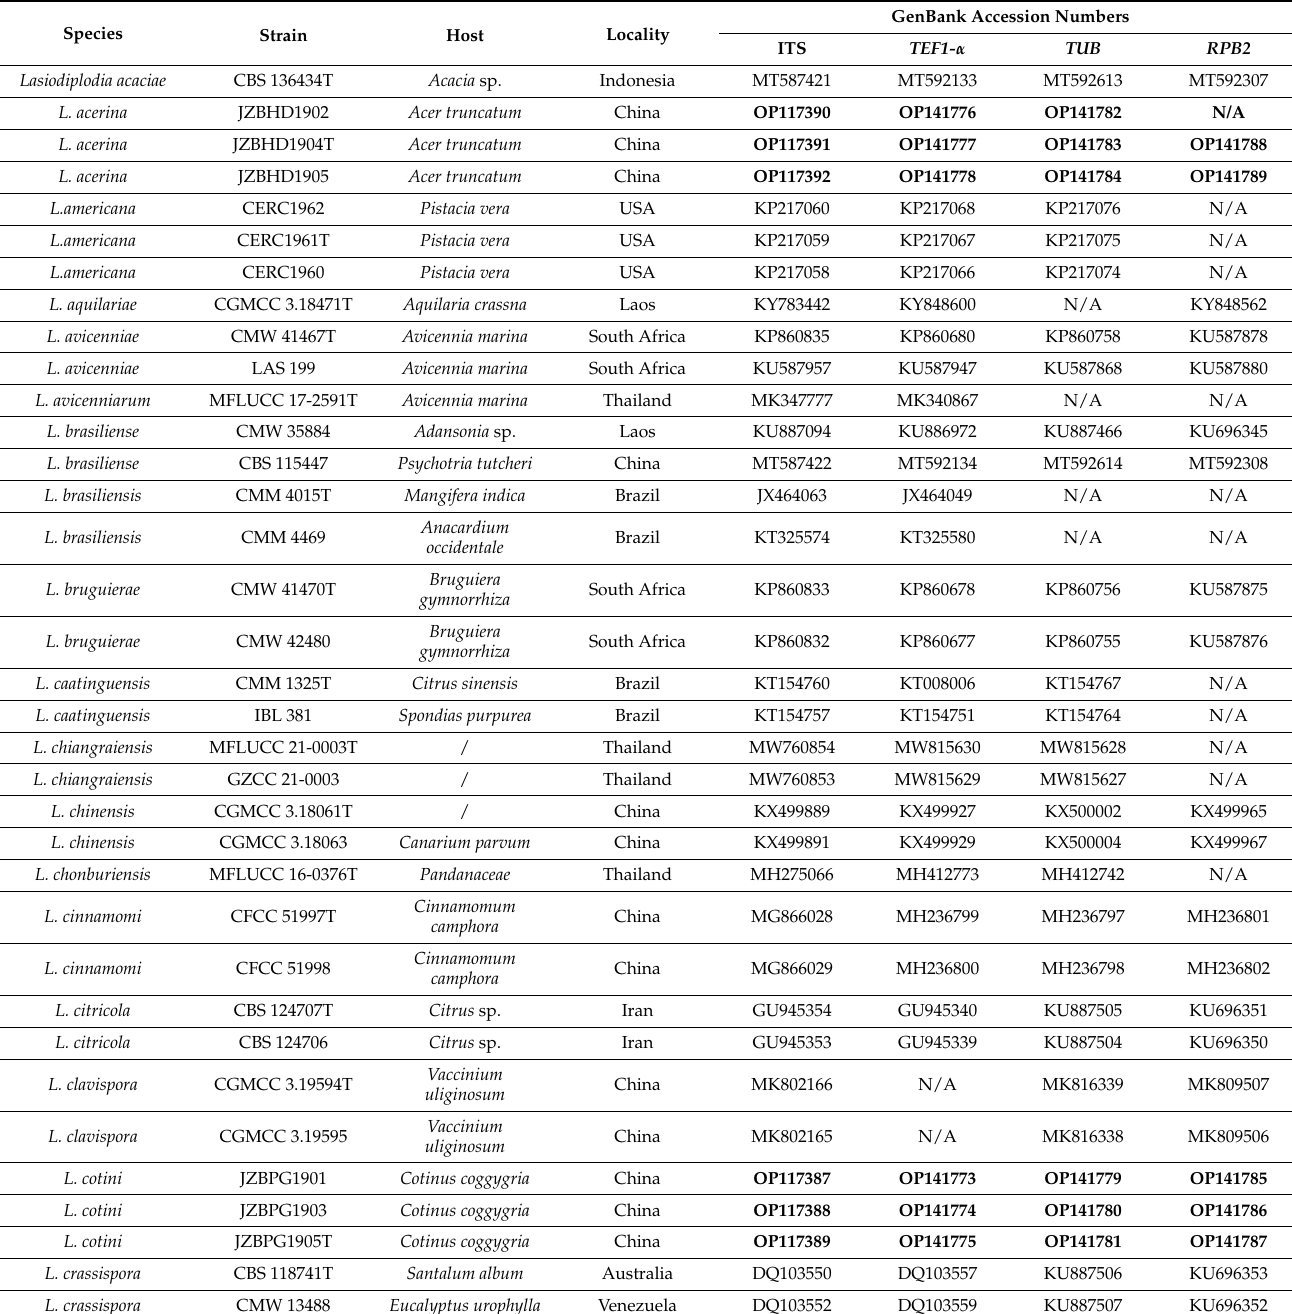
Table 1. Details of Lasiodiplodia strains investigated in this